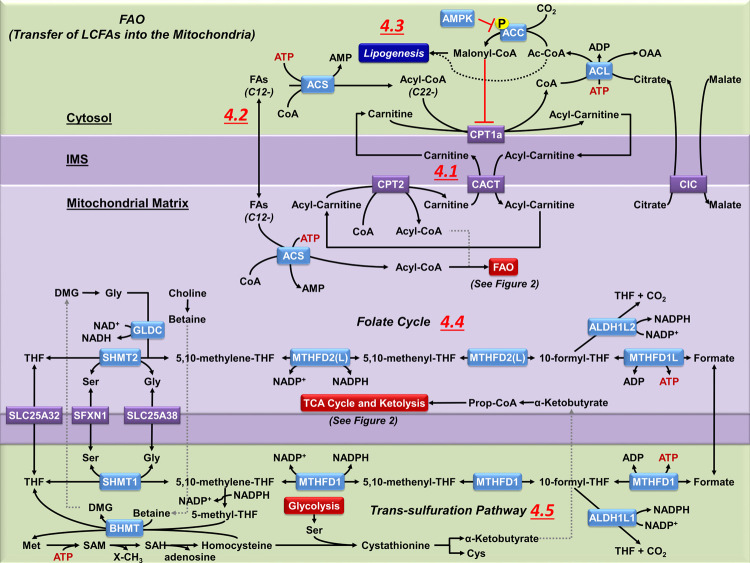
Mitochondrial carnitine shuttle, one-carbon folate metabolism and trans-sulfuration pathway. (4.1) Coenzyme A thioesters (Acyl-CoAs) cannot cross mitochondrial membranes. CPT1a facilitates the transfer of the acyl group from CoA to carnitine. Acyl-carnitines are permeable to the outer mitochondrial membrane, but not the inner mitochondrial membrane, requiring the transport via carnitine-acylcarnitine translocase (CACT) to reach the mitochondrial matrix. Once in the matrix, CPT2 converts the acyl-carnitine back to an acyl-CoA, which can then undergo FAO (see Figure 2.2). The released carnitine is then transported back across the inner mitochondrial membrane by CACT to be reused in the cytosol. (4.2) Non-esterified fatty acids of 12 or less carbons do not require the carnitine shuttle system, and can diffuse across both mitochondrial membranes. However, they still require esterification to CoA by mitochondrial ACS before they can be metabolized by FAO. (4.3) The carnitine shuttle system is regulated by malonyl-CoA, a precursor to FA synthesis which also inhibits CPT1a activity. Malonyl-CoA is principally produced from citrate that is broken into OAA and Ac-CoA in the cytosol by ATP citrate lyase (ACL). The released acetyl-CoA is carboxylated by ACC to malonyl-CoA. ACC is modulated by AMPK, which phosphorylates ACC and reduces its activity. (4.4) The folate pathway supports the transfer of one-carbon units from serine for biosynthetic processes. During this process both MTHFD2(L) and ALDH1L2 generate NADPH, which is essential for mitochondrial redox homeostasis. Despite the bidirectionality of this pathway, most of the cytosolic one-carbon units derived from serine are catabolized in the mitochondria. However, when the mitochondrial folate pathway is lost the directionality of the cytosolic one-carbon flux is reversed to compensate the synthesis of NADPH. (4.5) In the cytosol, MTHFD1 regenerates THF and the intermediate 5,10-methylene-THF links the folate pathway with the remethylation of homocysteine to methionine (Met) within the TSP. In the liver and kidney mitochondria, BHMT regenerates Met, linking the mitochondrial oxidation of choline to betaine with the TSP, but the presence of this pathway in brain cells has not been confirmed.